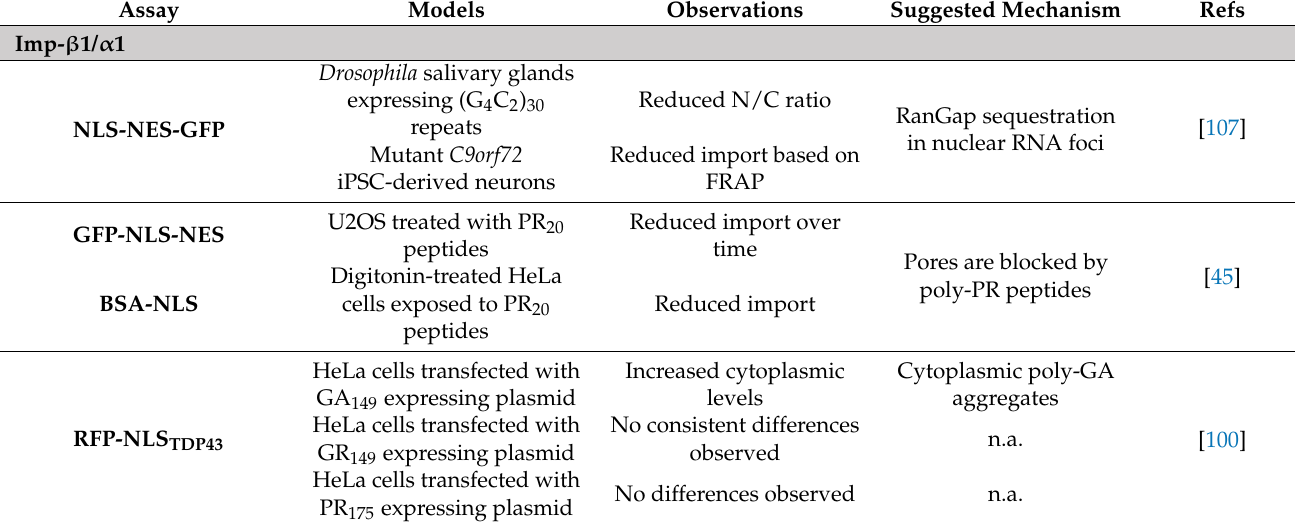
Table 4. Functional assays measuring different import pathways. Overview of the different assays used to measure the effects on nucleocytoplasmic transport. n.a.: not applicable. Assay Models Observations Suggested